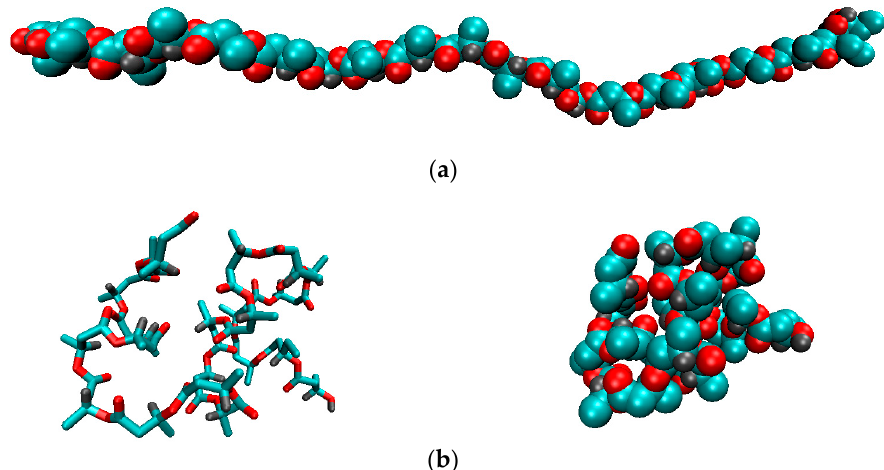
Figure 14. The initial configuration of the PHBV ( a ) (radius of gyration R g = 8.8 nm) and after 1 ns simulation in vacuum ( b ).